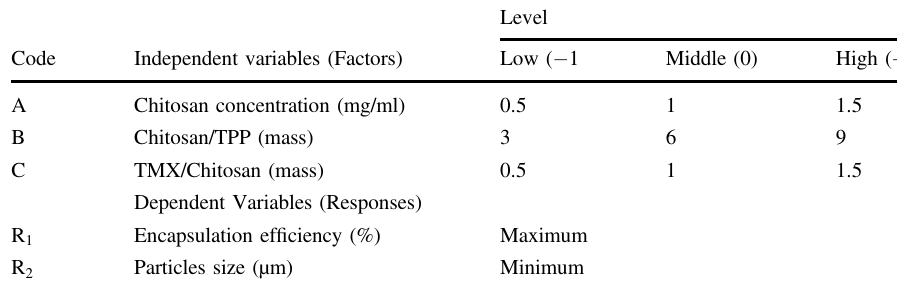
Table 1 Independent and dependent variables used in Box – Behnken